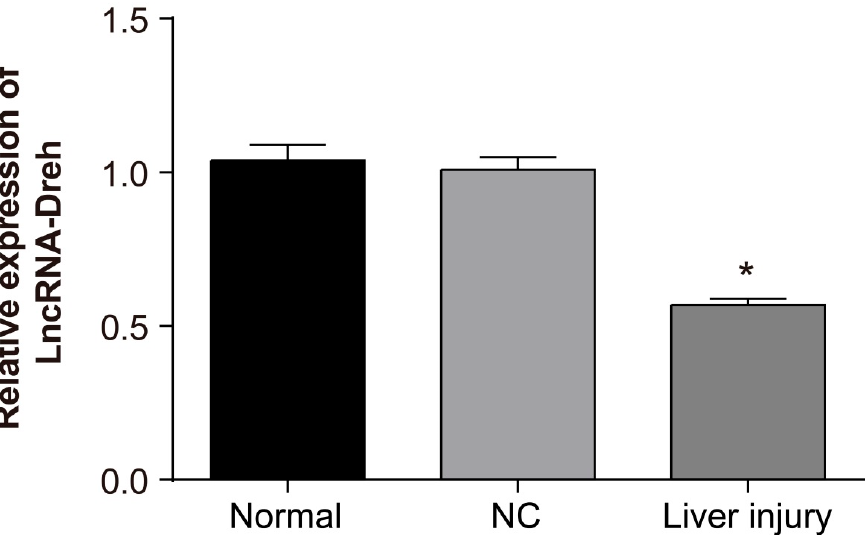
Figure 2. Liver tissues of rats with liver injury exhibit decreased LncRNA-Dreh. * p < 0.05, vs. the normal by water and NC groups by PEG solution. The results are given as means ± SD ( n = 10 rats). Statistical analyses were performed according to ANOVA with chi-square test ( p < 0.05).